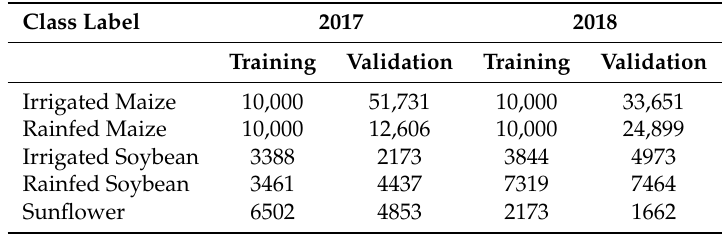
Table 5. Number of pixels for learning and validation of the model, for each class and for each year. Class